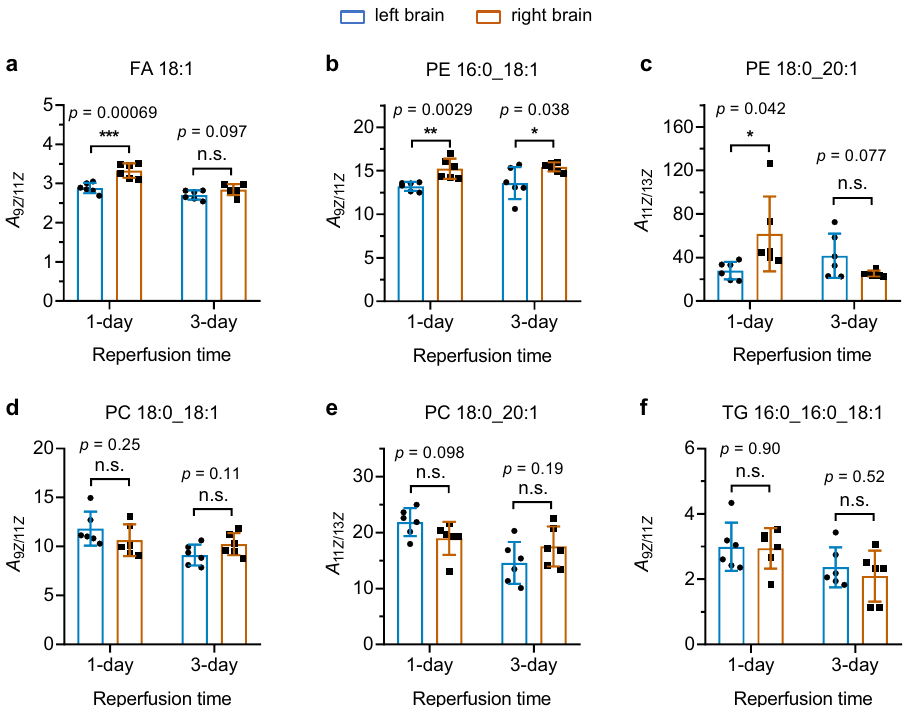
Fig. 6 Comparison of the C = C locational isomer ratios between left and right brains of MCAO model mice after 1-day and 3-day reperfusion. a – f Ratios of C = C locational isomers of ( a ) FA 18:1 FA 18:1 (9 Z /11 Z ), b PE 16:0_18:1 (9 Z /11 Z ), c PE 18:0_20:1 (11 Z /13 Z ), d PC 18:0_18:1 (9 Z /11 Z ), e PC 18:0_20:1 (11 Z /13 Z ), and ( f ) TG 16:0_16:0_18:1(9 Z /11 Z ) in left and right mouse brains. The C = C bonds were identi fi ed as Z con fi guration in these lipids using the proposed photoisomerization approach. The left brains were subjected to 1 h focal ischemia and then received reperfusion for 1 and 3 days. Two-sided Student ’ s t test was used without adjustment. * p < 0.05; ** p < 0.01; *** p < 0.001; n.s., no signi fi cant difference. Data are presented as mean values ±SD, n = 6 biologically independent Preparation of the bacterial samples . Four bacterial samples were used in this study, including one model pathogen in Arabidopsis resistance study ( Pseudomonas syringae , P. syringae ) and three endophytic bacteria isolated from Arabidopsis leaves ( Weizmannia ginsengihum , W. ginsengihum ; Pseudomonas citronellolis , P. citronellolis and Moraxella osloensis , M. osloensis ). To isolate the endophytic bac- teria, Arabidopsis thaliana Col-0 plants were grown in unsterilized soil at 22°C, with relative humidity of 60% and photoperiod at a 12:12 h light: dark cycle. 5 weeks later, mature leaves were detached and surface sterilized in 75% alcohol for 90sec, followed by washing with sterile water three times. Leaves were then dried on sterile fi lter papers. Three leaves were put into a 1.5mL Eppendorf tube fi lled with 500 µL 10mM MgCl 2 and one steel ball. Leaves were ground with a grinder. After brief centrifugation, the supernatant was plated on R2A plates, and bacteria